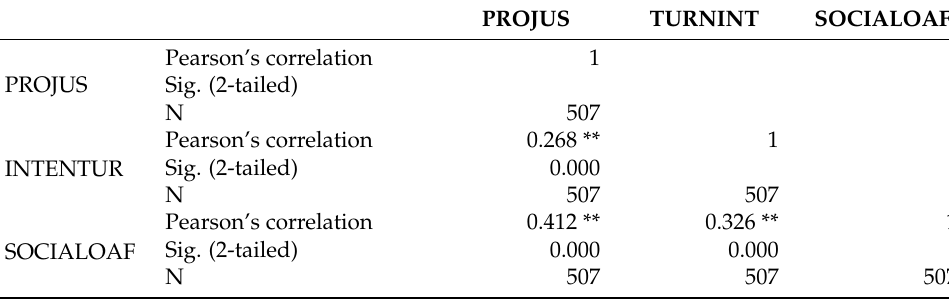
Table 3. Bivariate correlations (developed by the